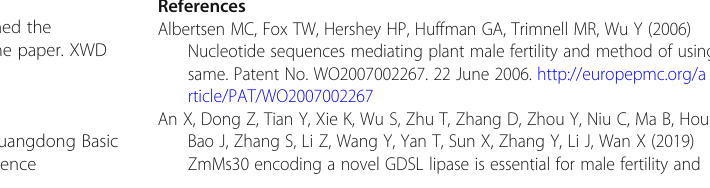
Abbreviations NMS: Nuclear male sterile; RFP: Red fluorescence protein; AGP: ADP-glucose pyrophosphorylase; AGPL: AGP large subunit; AGPS: AGP small subunit; amiRNA: Artificial microRNA; CMS: Cytoplasmic male sterile; Mt: Mitochondrial; PTGMS: Photoperiod/thermo-sensitive genic male sterile;